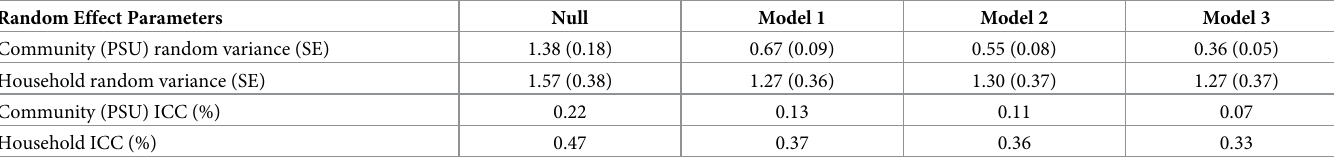
( Table 4 ) revealed a significant amount of variation across households and communities. Table 4. Variance estimates across families and communities, and intra-class correlation coefficient for the multilevel models for the use of sanitary napkin among adolescent